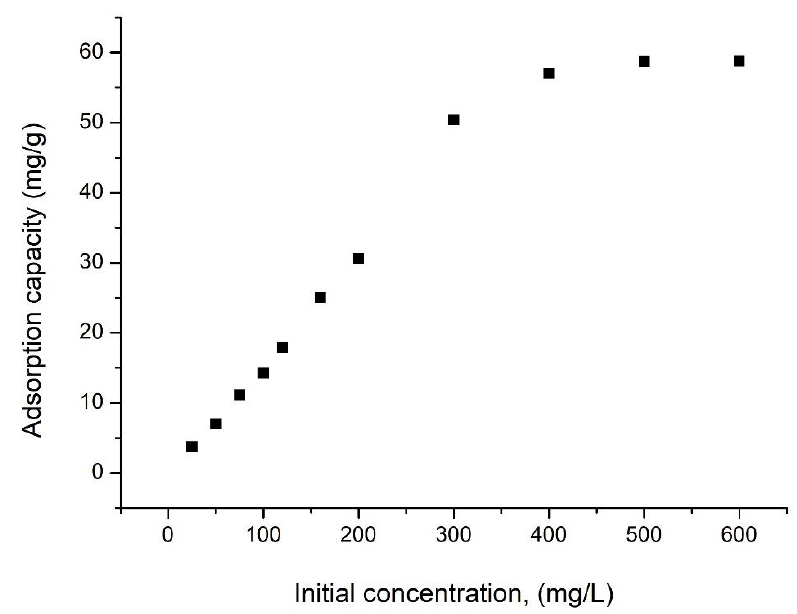
Figure 13. Effect of initial concentration on the adsorption capacity for SiO 2 FexOy sample.